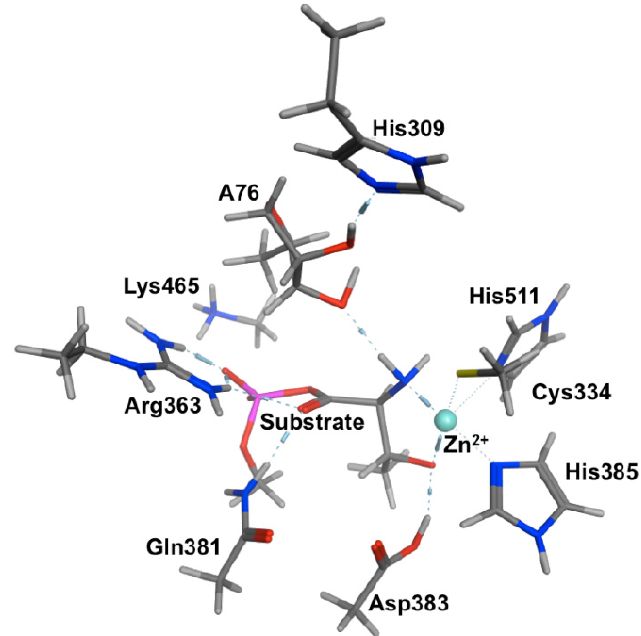
Figure 1. The Michaelis complex model (PRC) used for QM-cluster calculations in ThrRS including a neutral